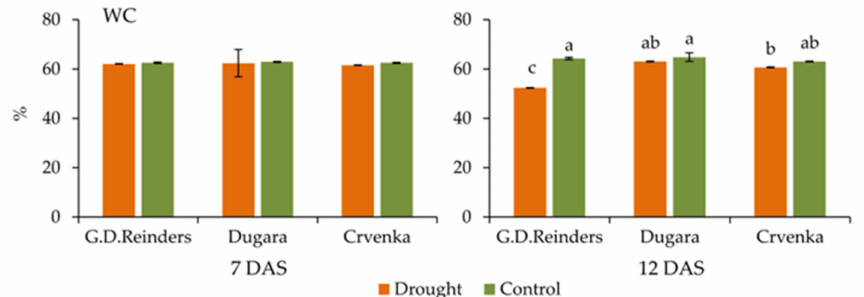
Figure 6. Water content in leaves measured in control and drought-stressed apple cultivars (“Golden Delicious Reinders”, “Crvenka” and “Dugara”) at 7 and 12 DAS (day after stress). Values are mean ± SE ( n = 3). Different letters indicate significant differences among treatments and cultivars at p < 0.05 according to the LSD